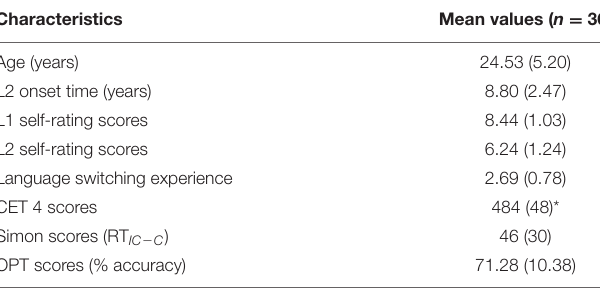
TABLE 1 | Mean values for individual difference measures.